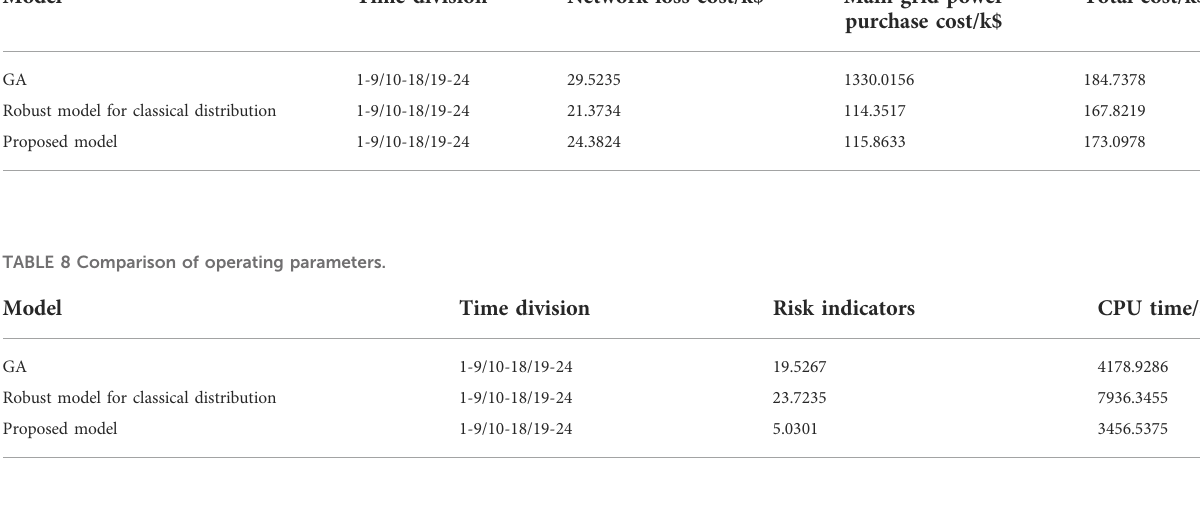
wind and light abandonment is effectively reduced.